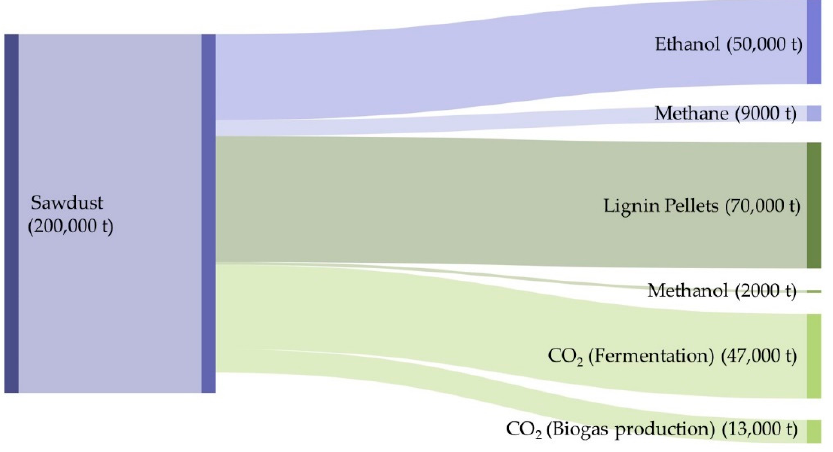
Figure 1. Annual feedstock input and ethanol and co-product outputs (DM) at the studied ethanol production plant [ton/year].